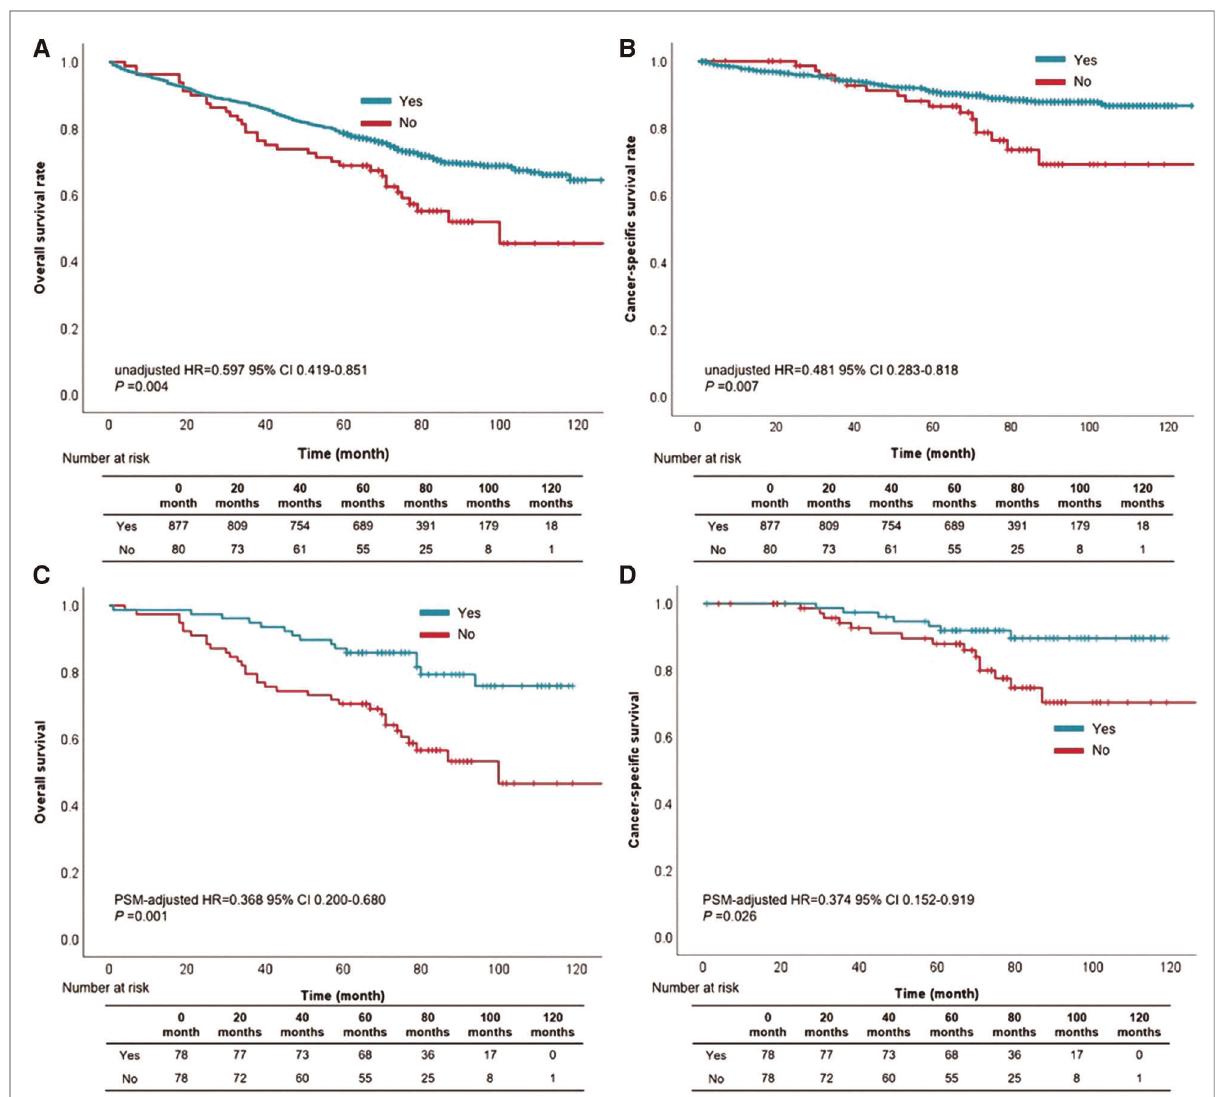
FIGURE 2 The survival curves based on waiting time within three months for overall survival ( A ) and cancer-speci fi c survival ( B ) the survival curves based on waiting time within three months for overall survival ( C ) and cancer-speci fi c survival ( D ) after propensity score